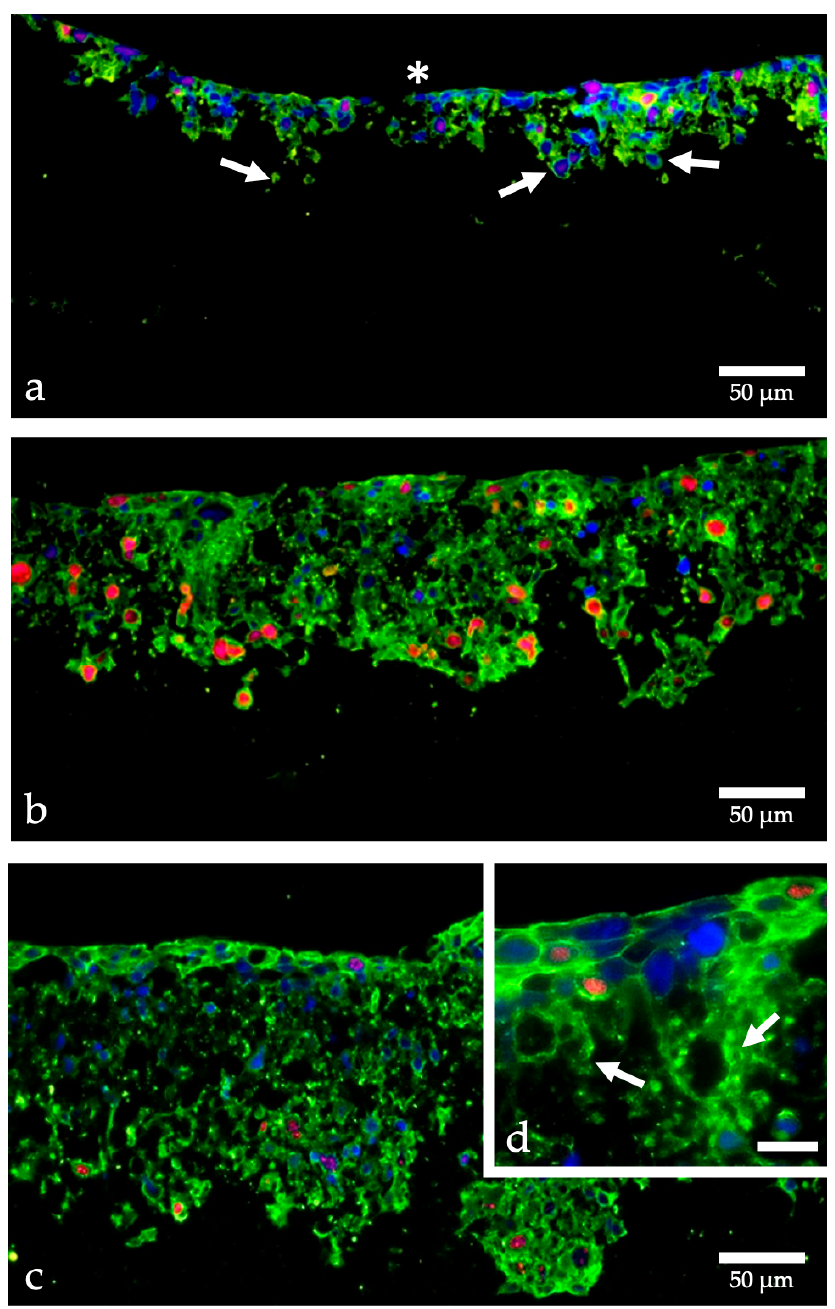
Figure 1. Proliferation of HT-1376 in strata membranes. Cells were grown in Alvetex Strata, fixed with PFA after 3 days ( a ), 13 days ( b ), and 19 days ( c , d ), embedded in paraffin, cut into 7 μ m thick sections and labeled with fluorescent dyes; cell nuclei blue, beta-actin green, Ki-67 red; ( a ) HT-1376 cells already migrate from the apical side (asterisk) into the membrane (arrows), the proliferation is moderate (red nuclei); ( b – c ) many more cells are found within the membrane and the proliferation rate is especially high in those migrating cells; ( d ) higher magnification shows the formation of a superficial multilayered tissue-like structure and indicates the migration of single cells through the membranous pores (arrows); images taken with an CKX53 microscope (Olympus, Hamburg, Germany); calculation of the proliferation rate using Image J. [23]; ( d ) scale bar indicates 20 µ